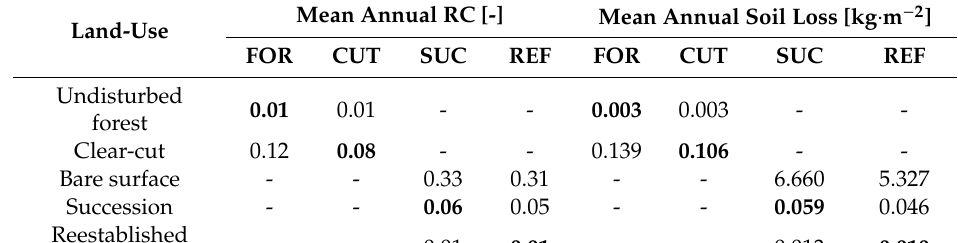
Table 14. Mean modeled annual runo ff and soil loss on standardized slope. Bold values represent current land use. Table 15. Mean modeled storm runoff and soil loss on standardized slope. Bold values represent current land use.